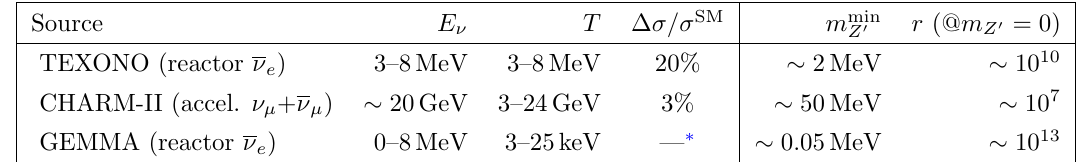
Table 2 . Con(cid:12)gurations of neutrino-electron scattering experiments. The last two columns for m min and r shows the threshold of the m Z 0 sensitivity [cf. eqs. (3.15)] and the enhancement factor Z 0 for a light Z 0 [cf. eq.